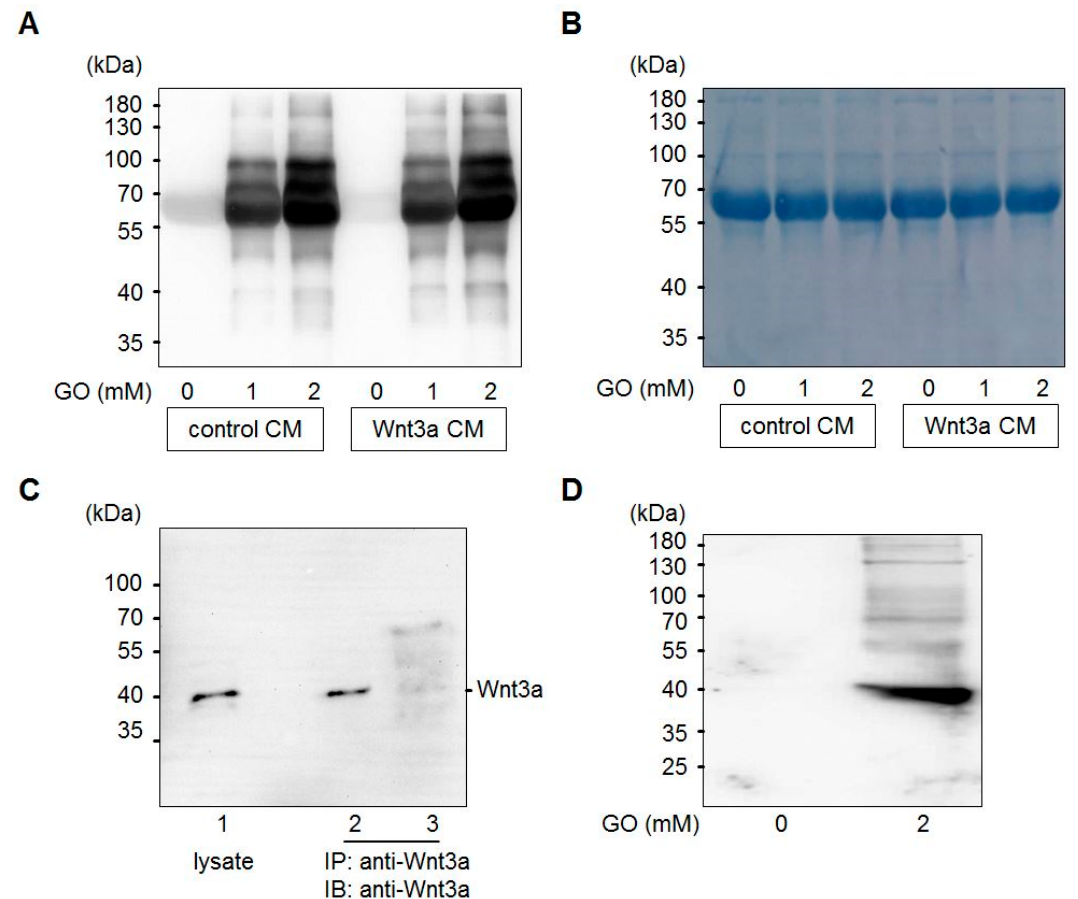
Figure 2. Glycation of conditioned media (CM) with GO. ( A ) Control CM and Wnt3a CM were treated with di ff erent concentrations (0, 1, 2 mM) of GO for 5 h and analyzed by SDS-PAGE and Western blotting with anti-CML26 antibody. ( B ) After Western blot detection the same membrane was stained with Coomassie brilliant blue to show equal loading. The strong band corresponds to bovine serum albumin of the cell culture medium. ( C ) Western blot detection of Wnt3a from L-M(TK-)Wnt3A cell lysates (lane 1) or immunoprecipitated from serum-free Wnt3a CM (lane 2) or GO-treated Wnt3a CM (lane 3). ( D ) Treatment of 0.5 µ g of purified Wnt3a protein with 2 mM GO induced Wnt3a carboxymethylation as detected with the anti-CML26 antibody on a Western blot. The untreated control was not